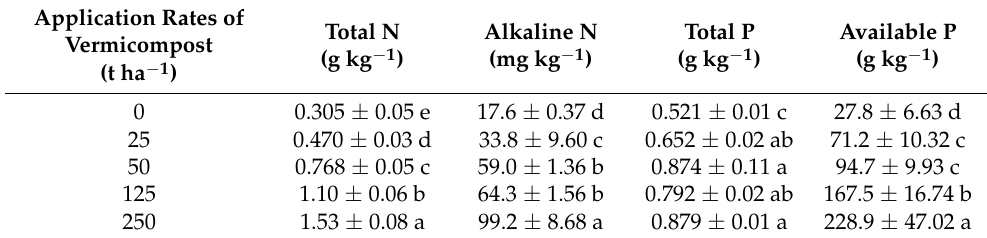
Table 2. Effects of vermicompost application on total N, alkaline N, total P, and available P contents in mudflat salt-affected soil.